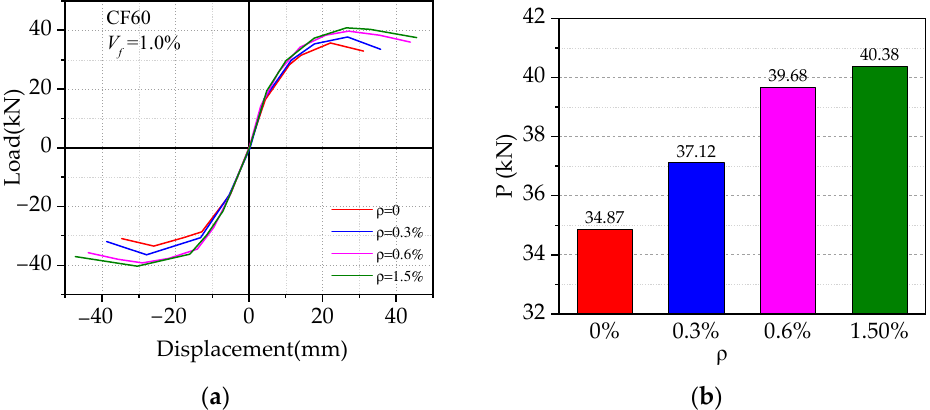
Figure 13. Effect of the stirrup ratios in the core area: ( a ) comparison of skeleton curve; ( b ) comparison of peak load.